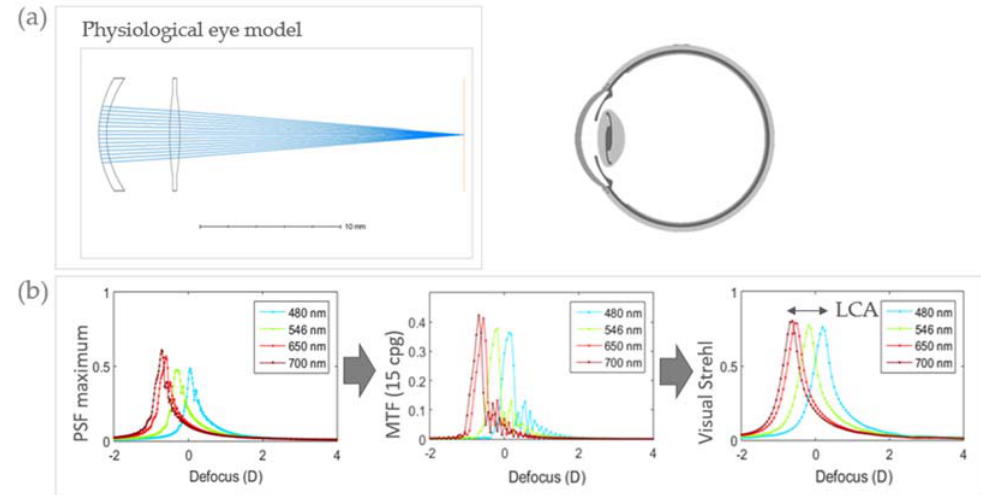
Figure 2. Illustration of the computational ray tracing methodology. ( a ) Representation of the pseu- dophakic physiological eye model in Zemax to simulate implanted IOL eye conditions. ( b ) Optical quality metric flow chart. LCA and chromatic difference of focus were obtained from the TFVS curves for the different wavelengths (480–700 nm).